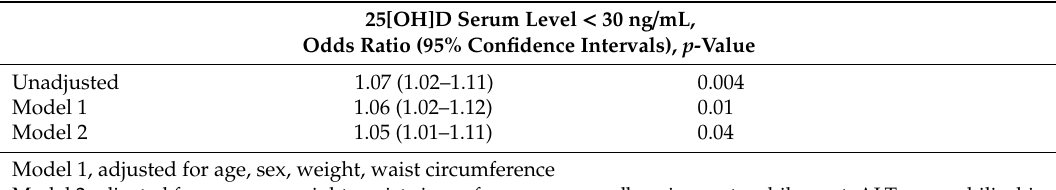
Table 6. GGT and the risk of 25[OH]D deficiency / insu ffi